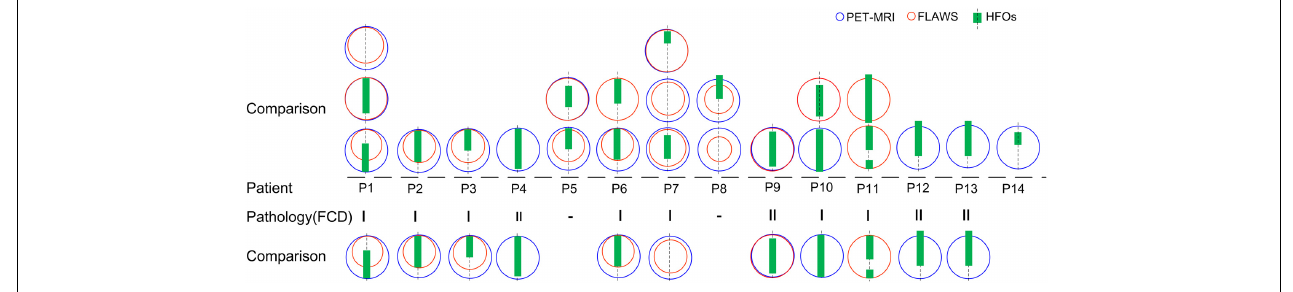
FIGURE 3 | Comparison of HFO-fast ripple (FR) marking and lesions detected by neuroimaging. A comparison of the extent of areas marked using the three methods in 14 patients is shown (patient #15 was not shown as no FR was detected); blue and red circles represent PET-MRI and FLAWS, respectively. Green rectangles represent HFO-FR-marked areas of the implanted electrodes (symbolized by the black imaginary line). Lesions classified as FCD were further compared, and HFO-FR-marked areas even extend beyond the FCD lesion.